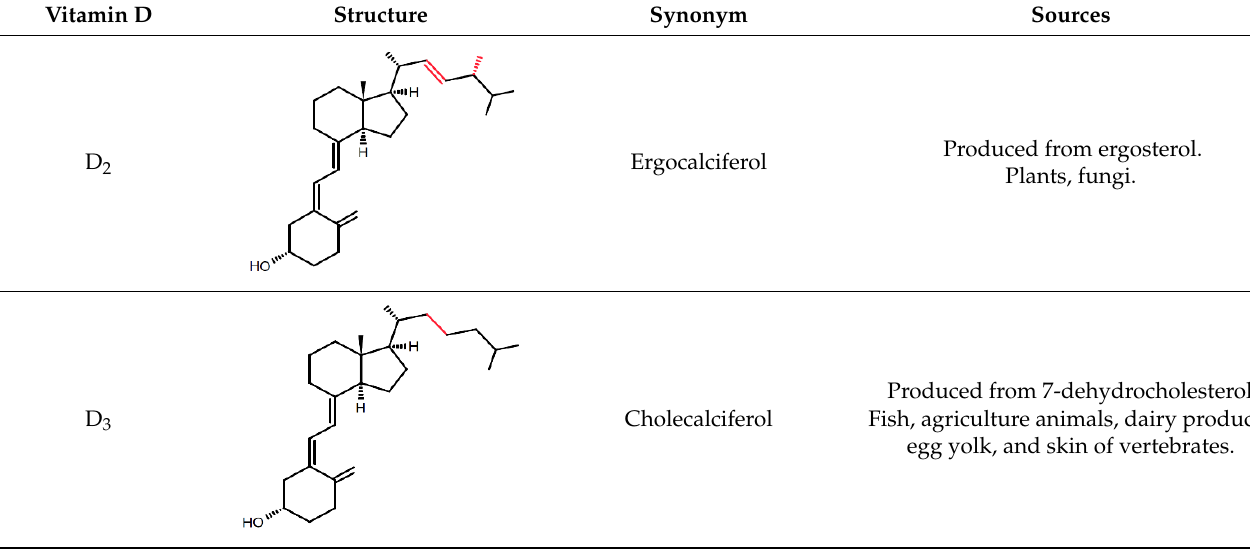
Table 1. Natural analogs of vitamin D and their structures and sources [30,35–37]. Vitamin D Structure